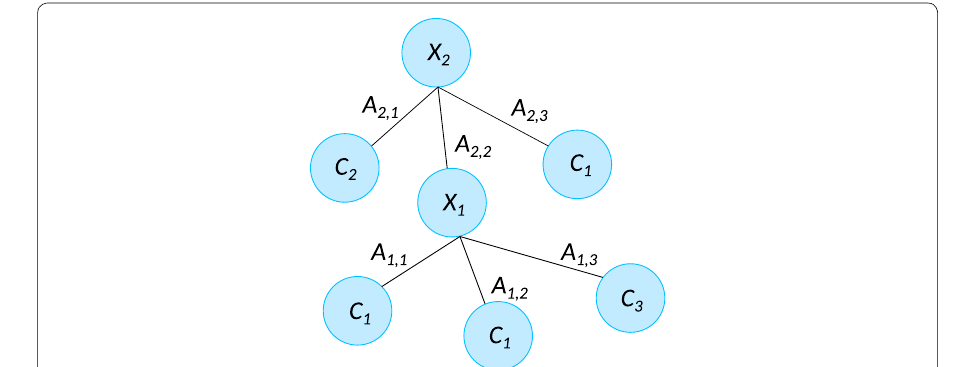
Fig. 2 An example of multi-way Fuzzy Decision Tree